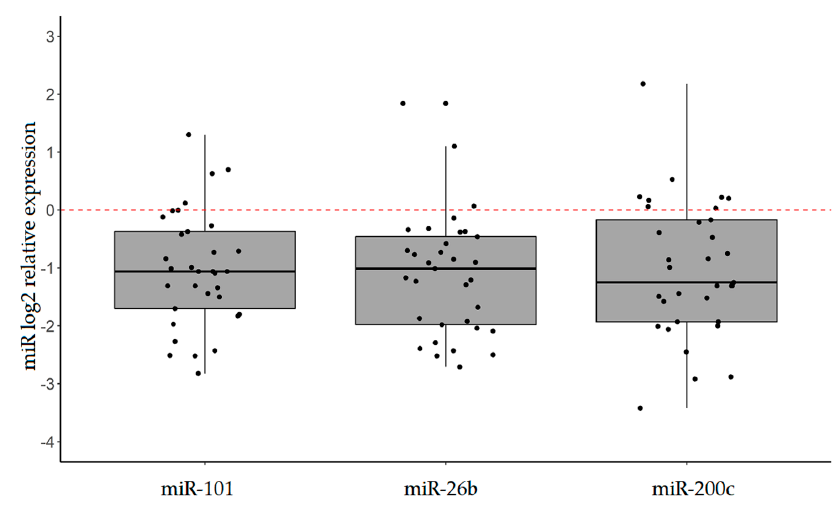
Figure 2. miR expression analysis by RT-qPCR. Box plots of miR-101, miR-26b, and miR-200c expression (log2 FC) in 33 intestinal gastric cancer (IGC) patients. RNU6 was used as the internal control. p -value < 0.001 for all miRs (paired student t -test).